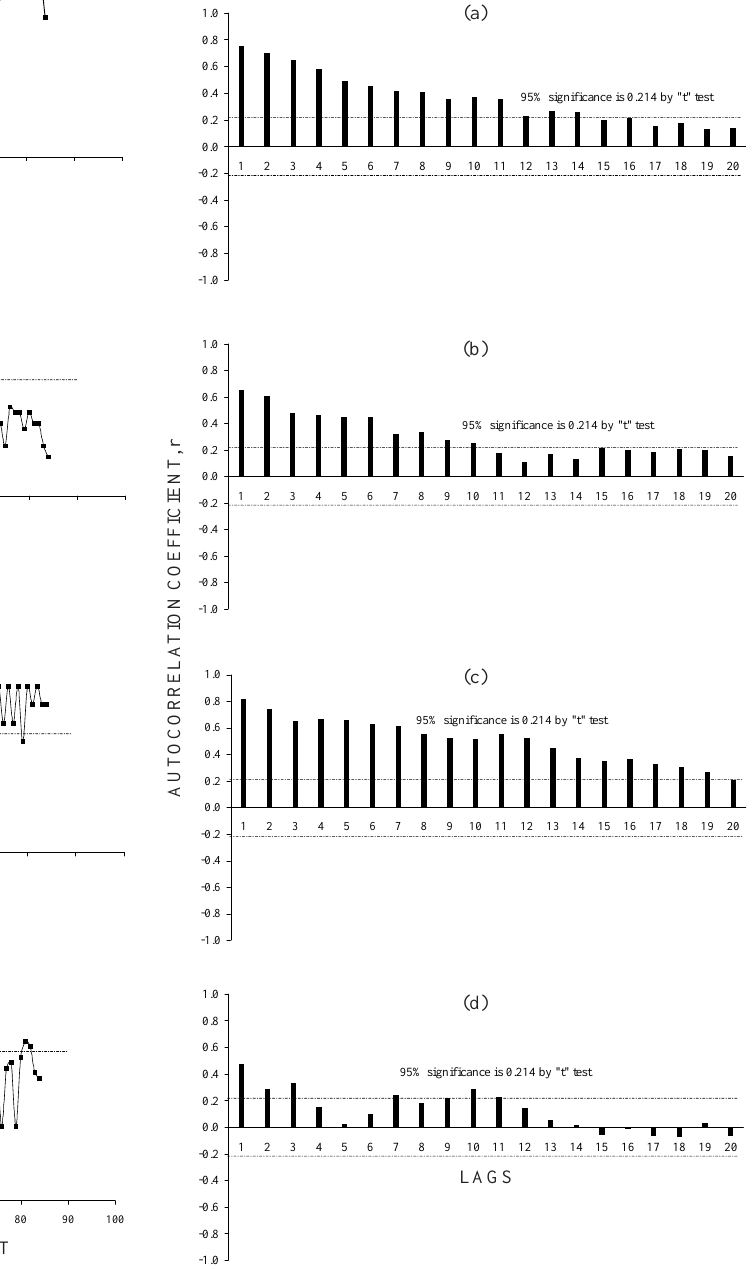
Figure 2. Calculated autocorrelation function (ACF) for soil water content data (a); soil organic matter data (b); clay content data of (1c) (c); and aggregate stability data